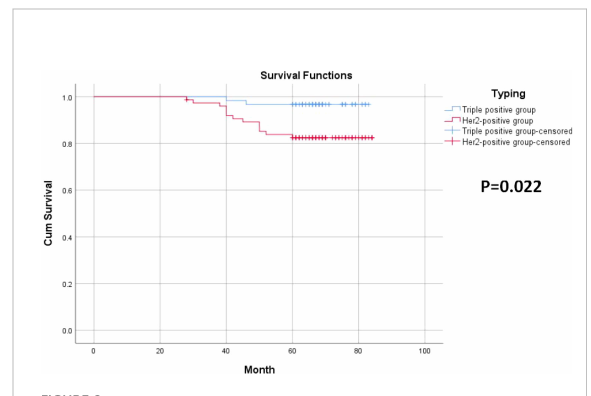
FIGURE 2 5-Year overall survival curves for the two groups of breast cancer